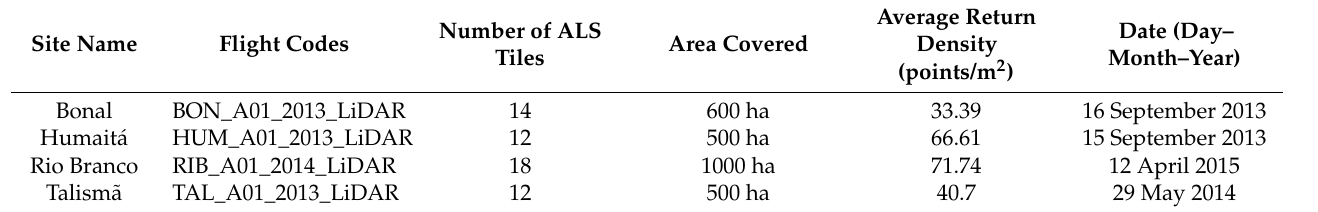
Table A1. Information in ALS data including acquisition data, average point density, area coverage, and flight codes. Data come from the Sustainable Landscapes GeoNetwork Catalog.